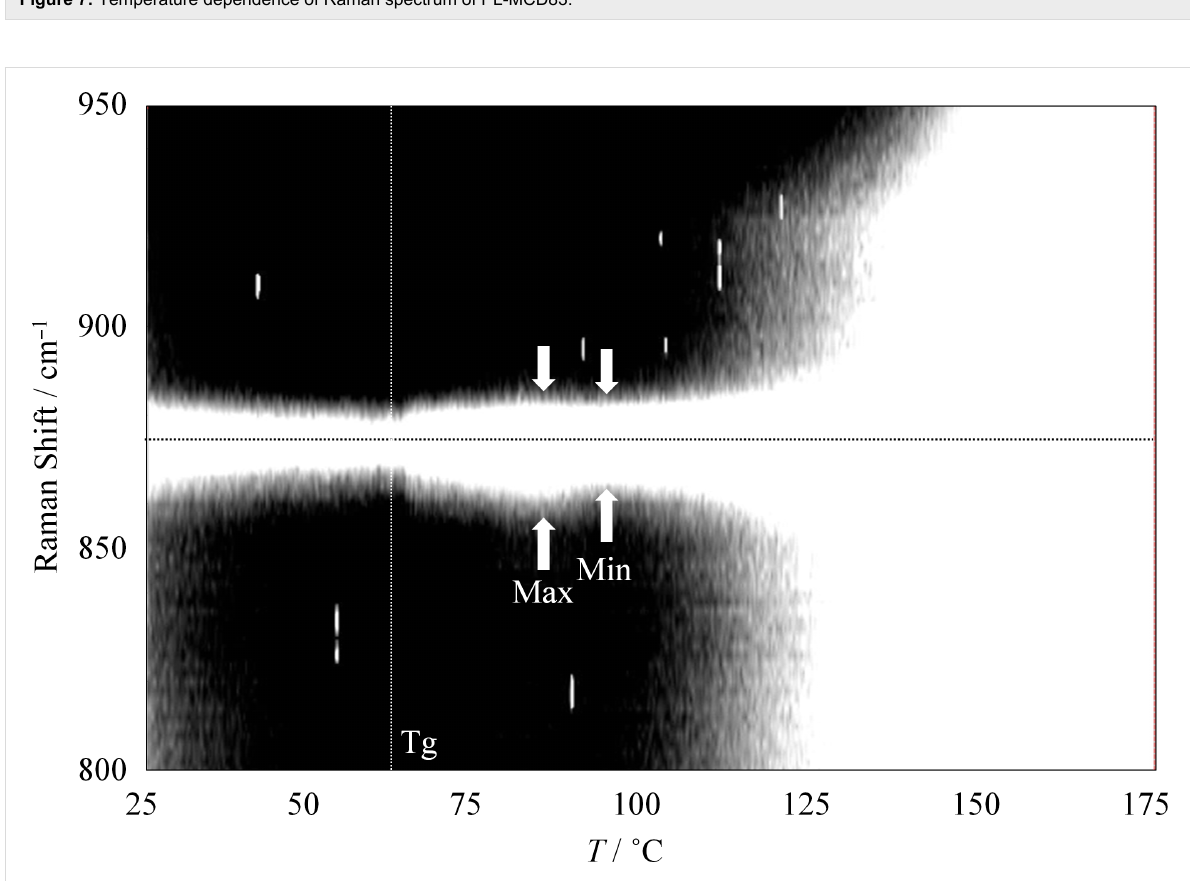
Figure 8: Stacked line profiles of Raman spectra of PL-MCD83 for the characteristic peak of PLLA at 873 cm − 1 .